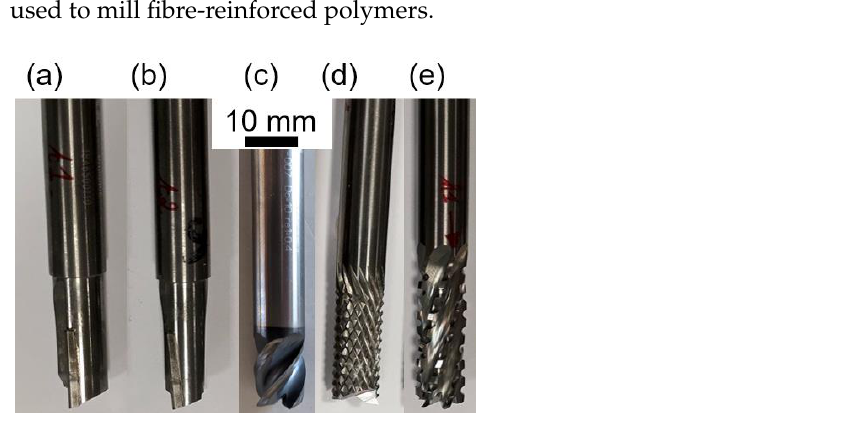
Figure 5. Some tool geometries for milling composites: ( a ) straight flute, ( b ) straight helical flute, ( c ) helical tool, ( d ) burr tool (pyramidal tooth shape) and ( e ) fluted burr tool or satcut tool (trapezoidal tooth